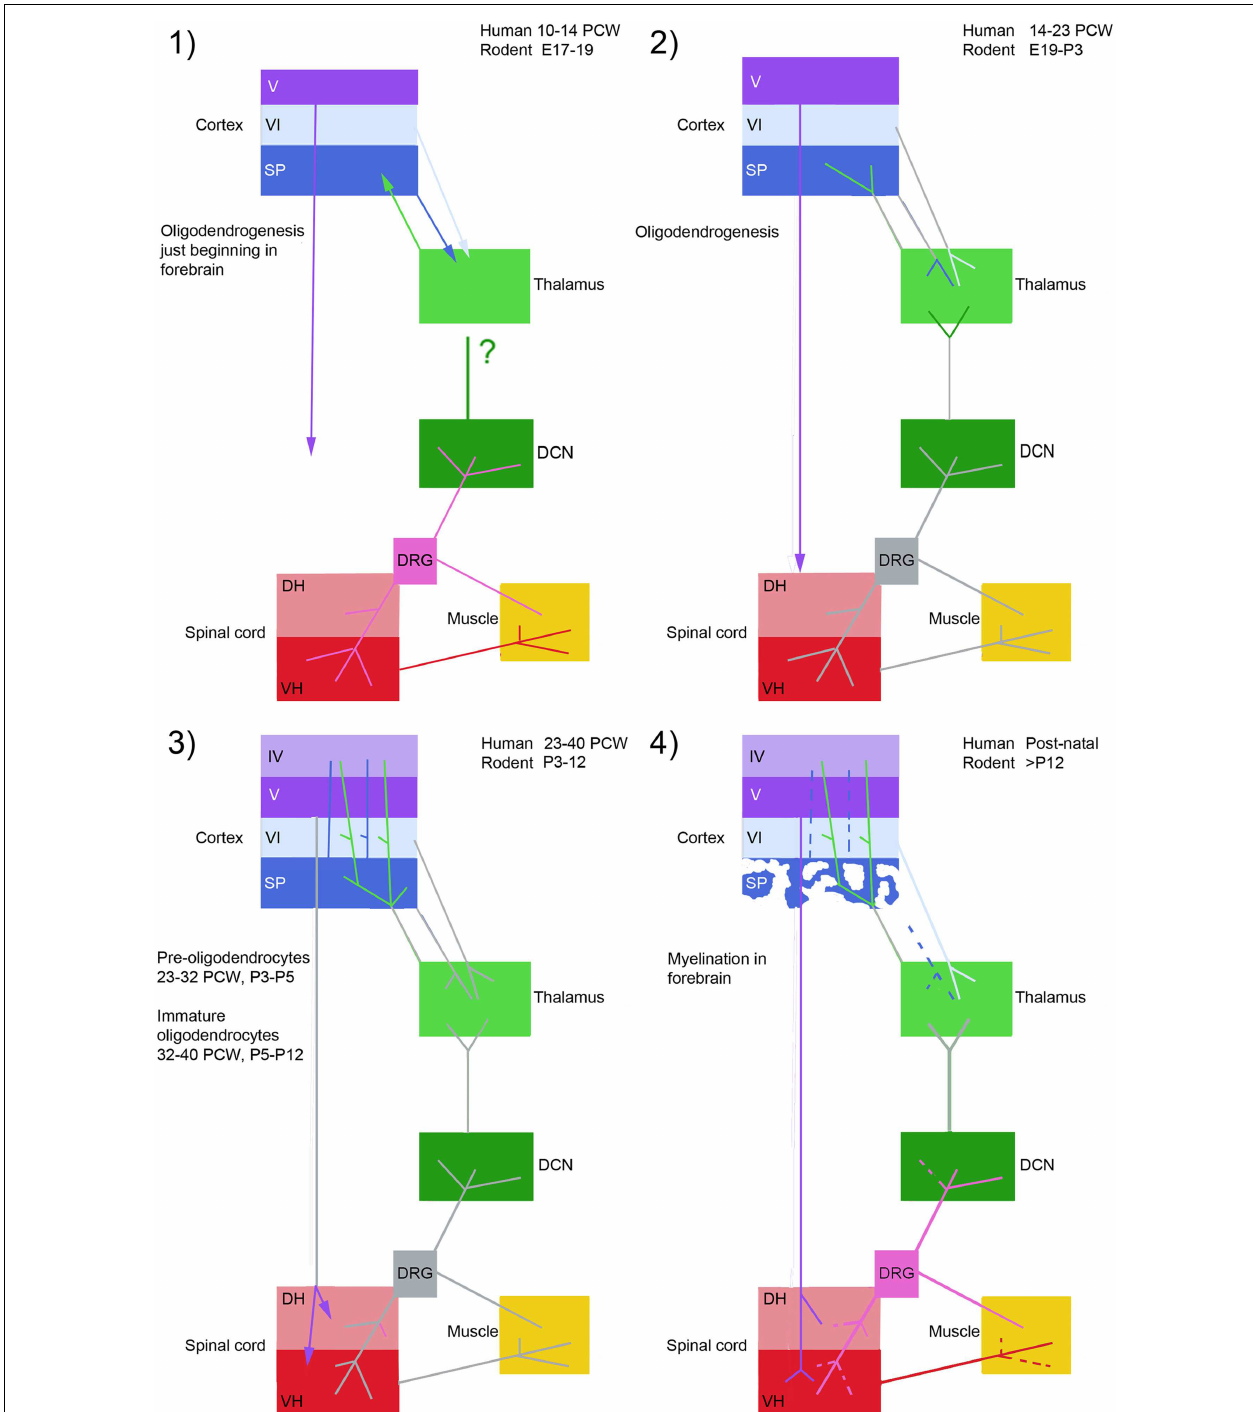
Spindle bursts in response to spontaneous movement are recorded in somatosensory cortex. Stage 4; the subplate dissolves and corticospinal connections and muscle afferent projections are refined in the spinal cord and dorsal column nuclei. DCN, dorsal column nuclei; DH, dorsal horn; DRG, dorsal root ganglion; SP, subplate;VH, ventral horn; IV,V,VI, cortical layers. Arrows represent ingrowth of axons, dashed lines withdrawal of axon terminals. Axon projections colored gray have not changed at that stage in the figure. Based on information from Ref. (42, 50, 57, 75, 92, 100,